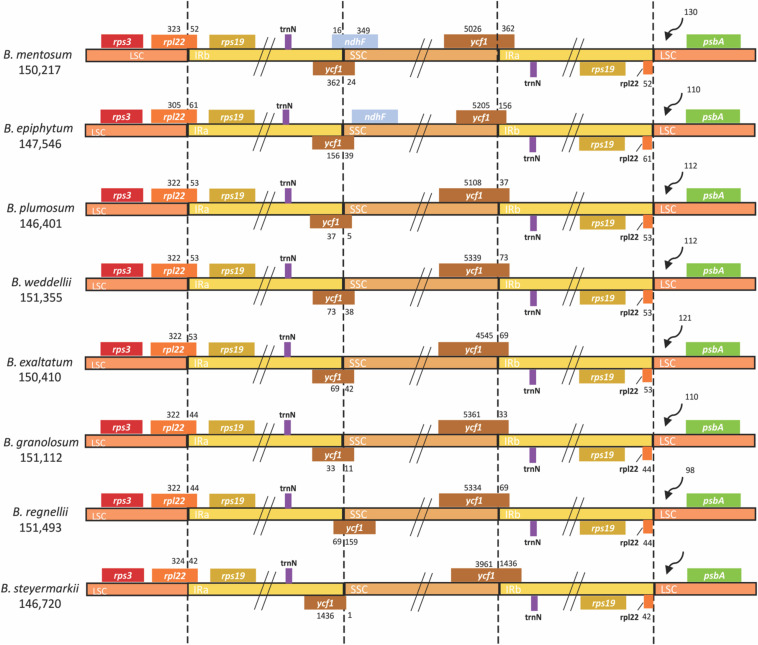
Comparison of LSC, IR, and SSC junctions in eight Bulbophyllum plastid genomes. Genes shown on the top are transcribed in reverse, and those shown underneath are forward. LSC, large single copy; IR, inverted repeated; SSC, small single copy.